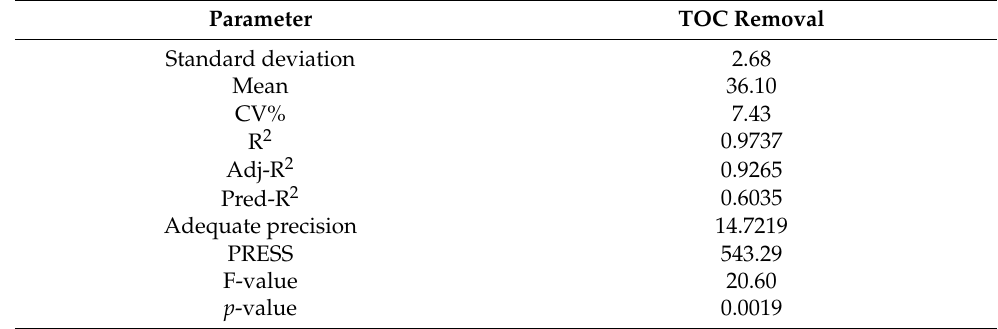
Table 2. ANOVA results of the RSM model for the continuous flow UV/PS/ZVI treatment of synthetic